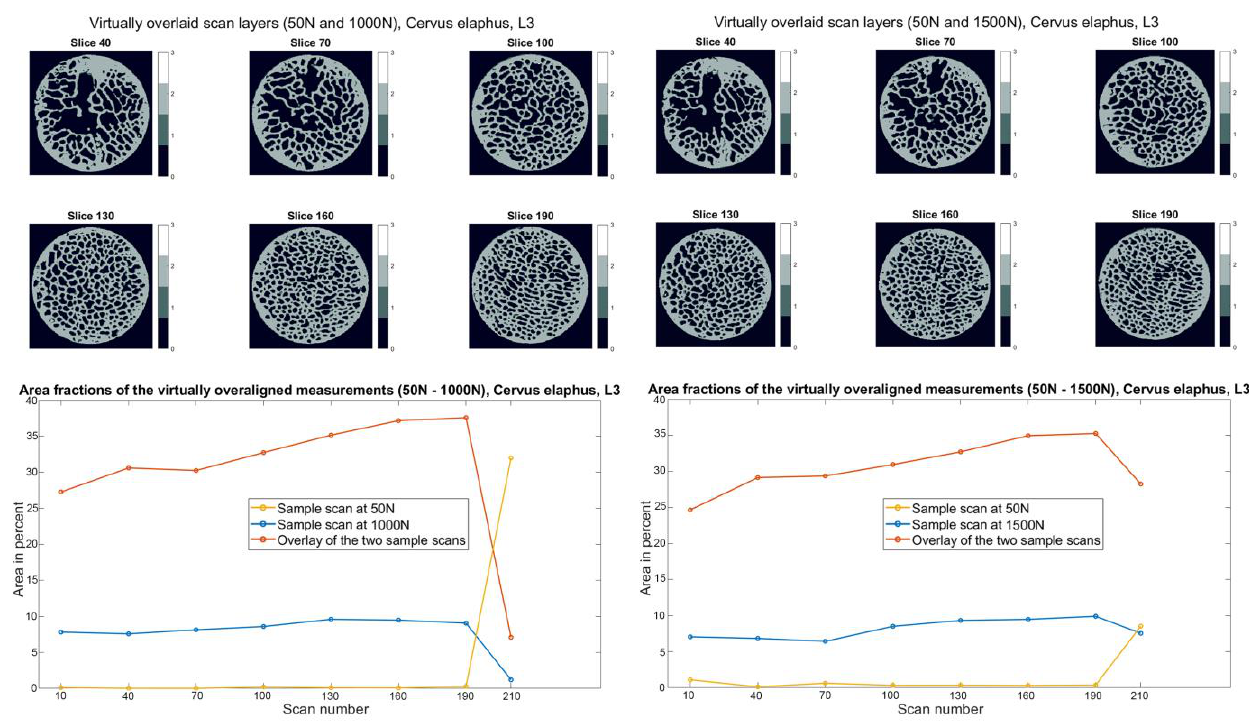
Figure 9. Slice view of the virtually superimposed 3D images (50 N and 1000 N, 50 N and 1500 N) from the Cervus elaphus L2 sample ( top ). The different components are declared in each layer with numbers from 0 – 3 and the corresponding color. 0 Background, 1 Sample image (1000 N/1500 N), 2 Superimposed areas of the two 3D images, 3 Initial images (50 N). The course of the area fractions of the sample image (1000 N/1500 N), source image (50 N), and the superimposed area over the different layers are summarized in a diagram.